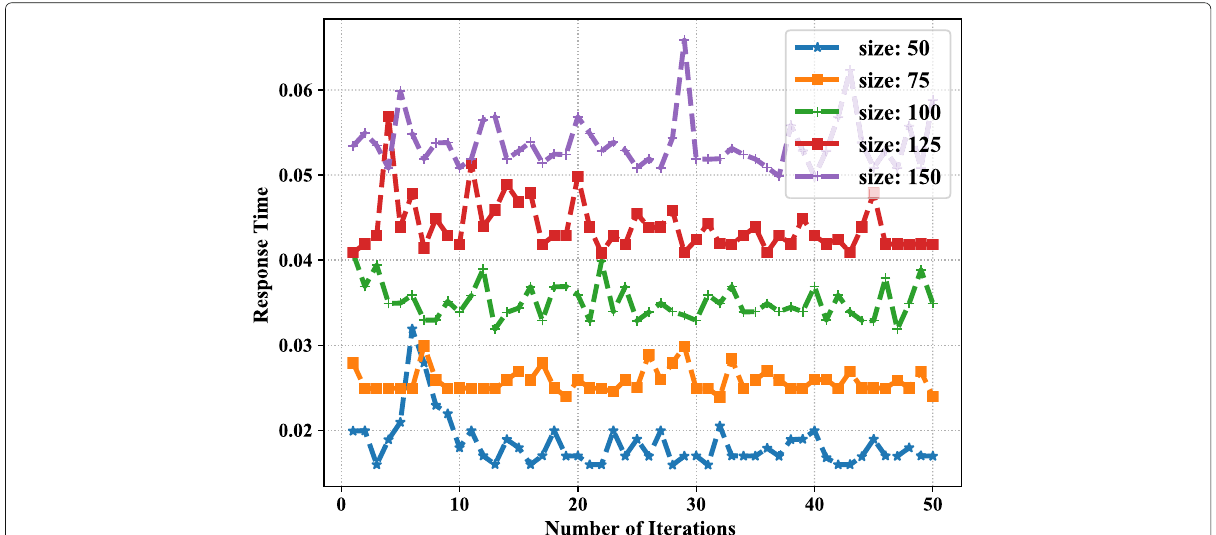
Fig. 9 Response times with different values of population